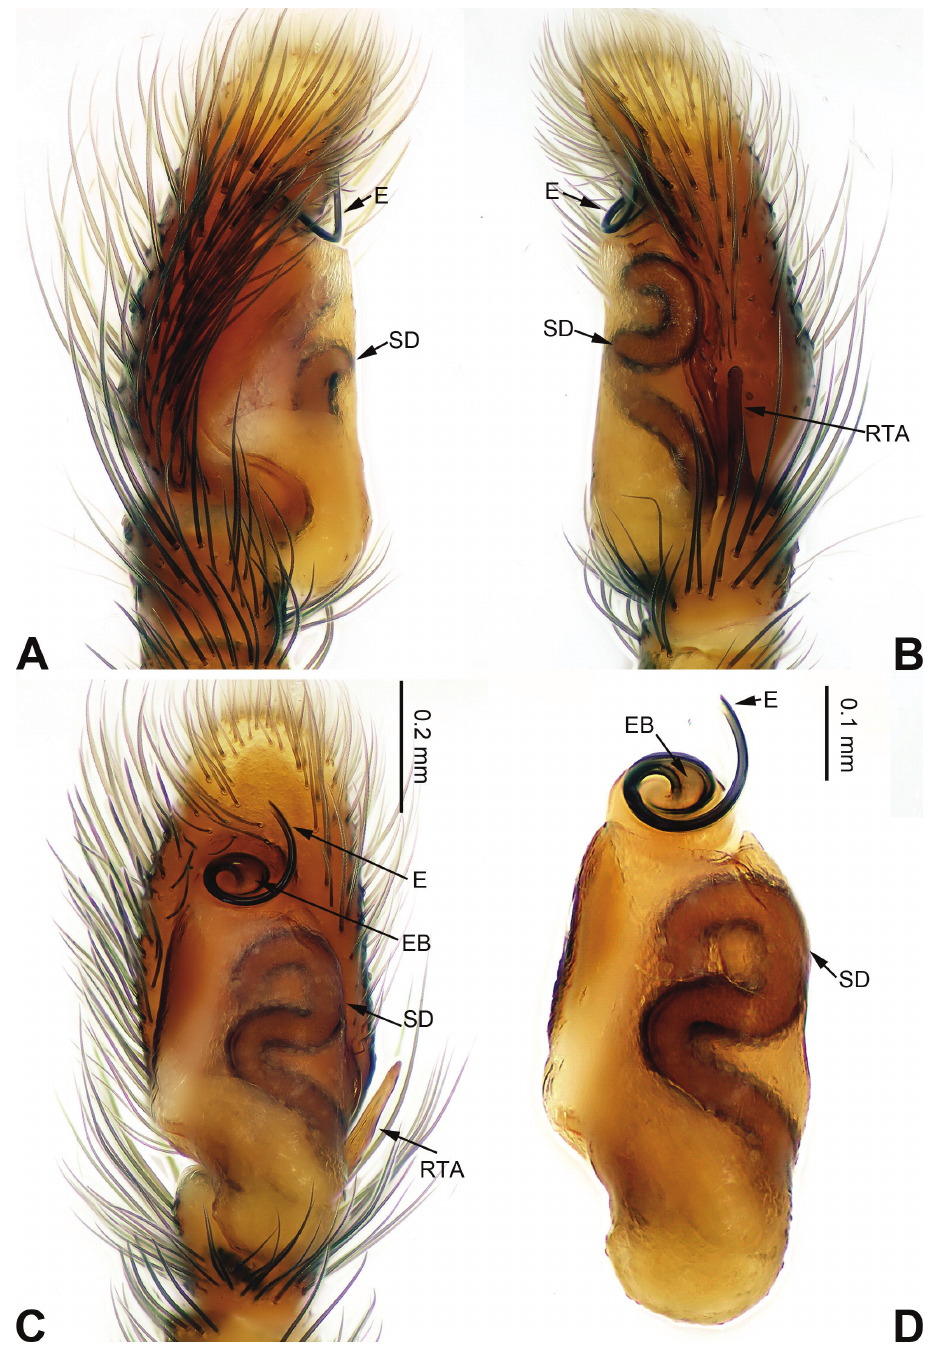
Figure 15. Palp of Chinophrys mengyangensis sp. n., male holotype. A prolateral B retrolateral C ventral D bulb, ventral. Scale bar equal for A–C